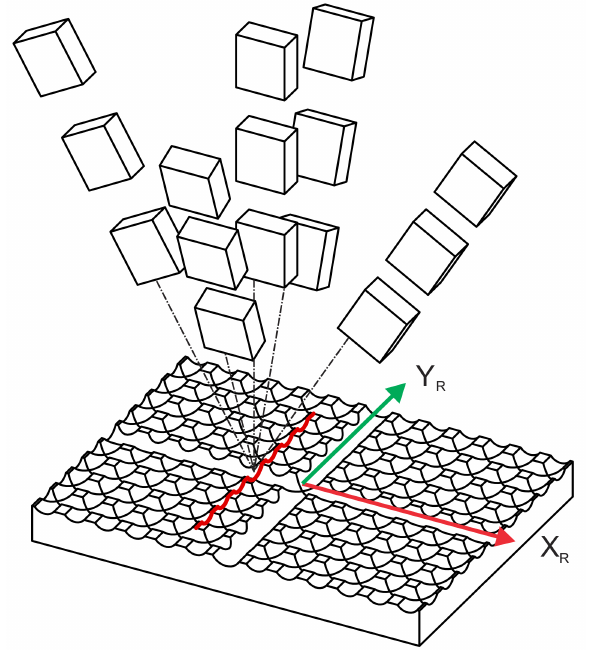
Figure 4. Poses of laser profilometer during the scanning of the reference